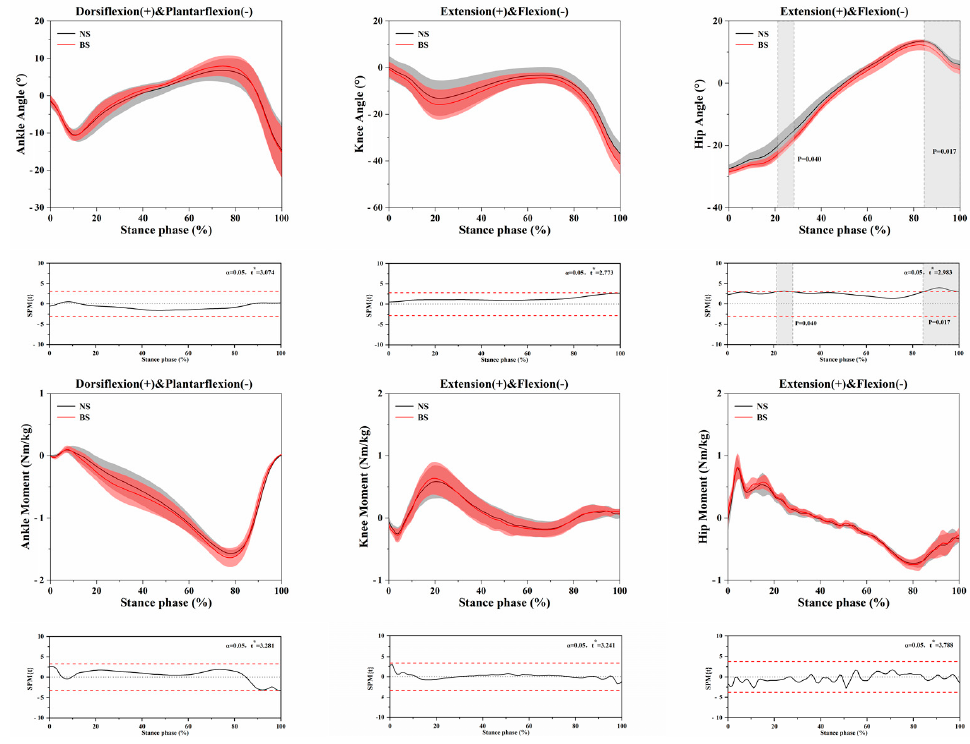
Figure 4. Illustration of the results between the NS and BS lower limb showing the statistical parametric mapping outputs for the angle and moment of the ankle, knee, and hip during the walking stance phase. The values of t* are shown on the left of each image. Grey shades represent the significant differences and t -values of the statistical parametric mapping (SPM) for all participants (post hoc results; dashed red lines represent the results at p = 0.05). NSs, normal shoes; BSs, bionic shoes.